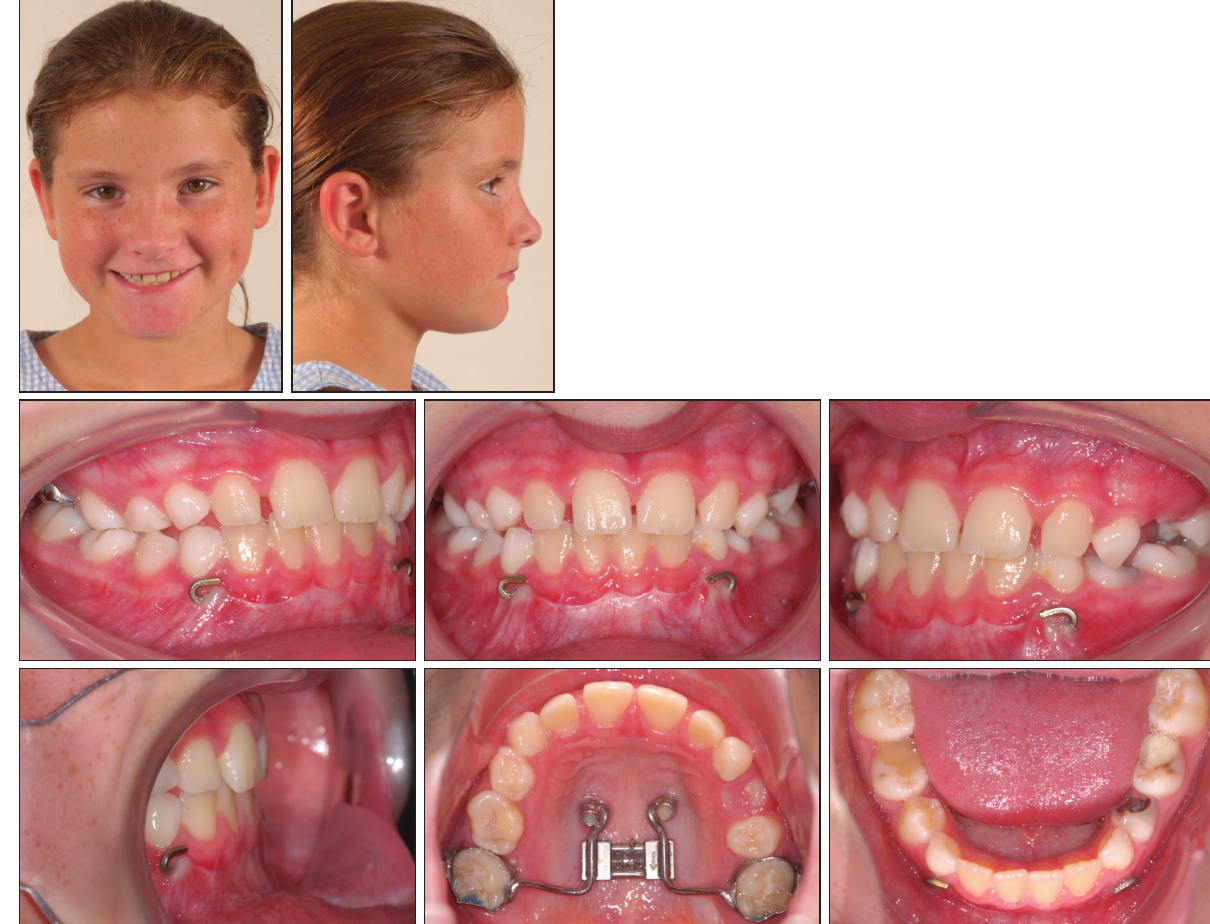
Figure 6. Post-treatment photographs of a female patient treated with the Hybrid Hyrax-Mentoplate protocol from the present